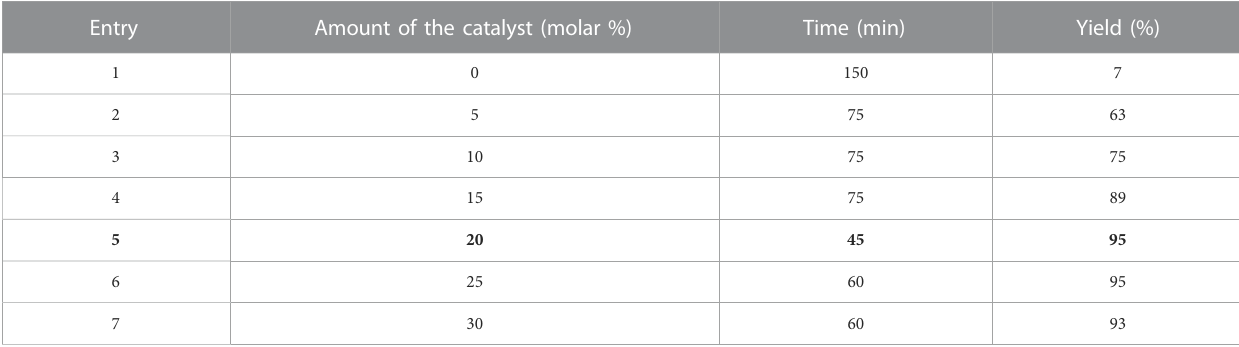
TABLE 1 Optimization of reaction conditions for the synthesis of IIA using magnesium oxide nanoparticles.